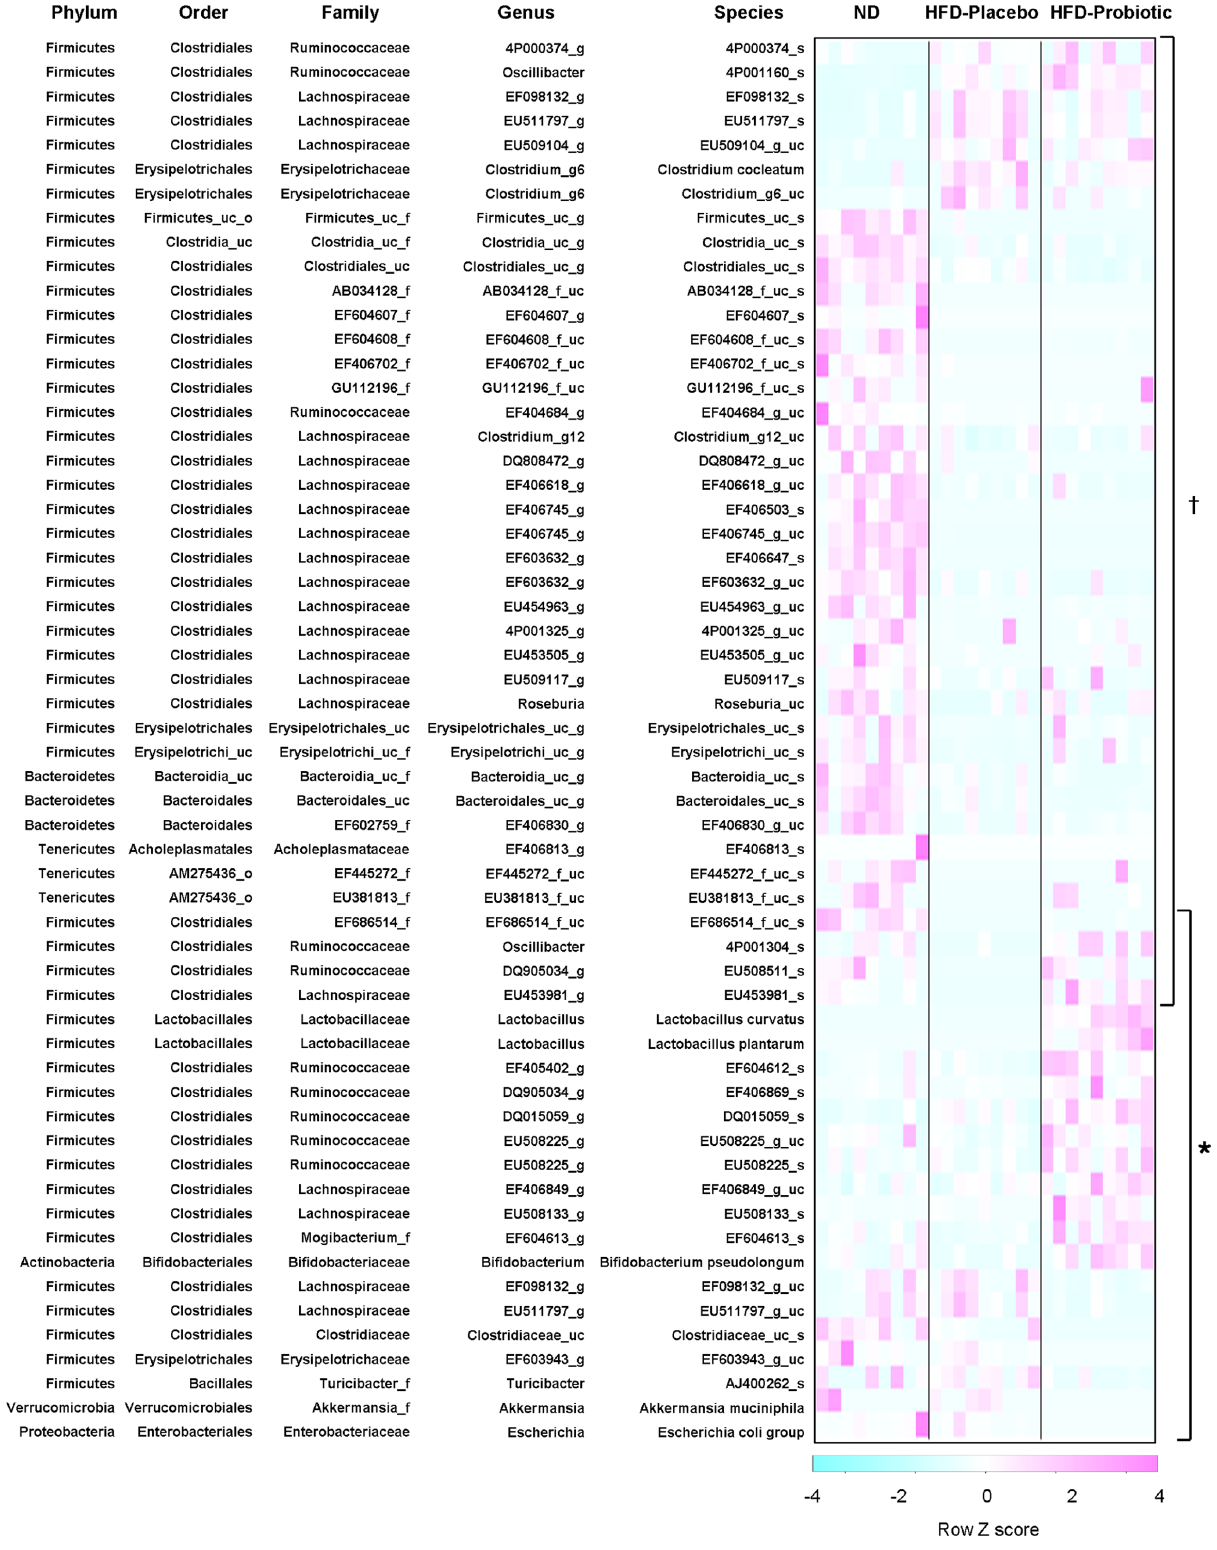
Figure 4. High-fat diet and probiotic effect on gut microbiota composition at the species level. Heatmap of the relative abundance of microbial species altered by diet-induced obesity or probiotic treatment. Data represents row scaled Z-scores. Significant differences between HFD- placebo versus ND are indicated as { p , 0.05. Significant differences between HFD + probiotic versus HFD + placebo are indicated as *p , 0.05.